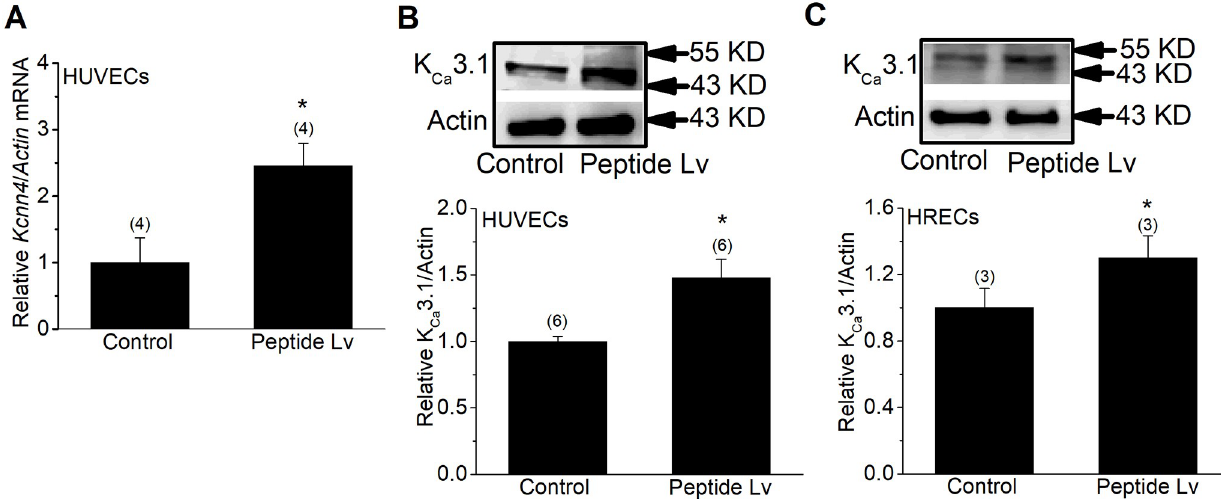
Fig 3. Peptide Lv increases the mRNA and protein levels of K Ca 3.1 ( Kcnn4 ) in ECs. Endothelial cells were treated with PBS (vehicle control) or peptide Lv (500 ng/ml) for 4 hours and processed for qPCR or immunoblotting. Peptide Lv increased the mRNA (A) and protein (B) levels of K Ca 3.1 in cultured HUVECs. (C) Peptide Lv also increased the protein level of K Ca 3.1 in HRECs. Student’s t -test was used for statistical analyses; � p < 0.05.